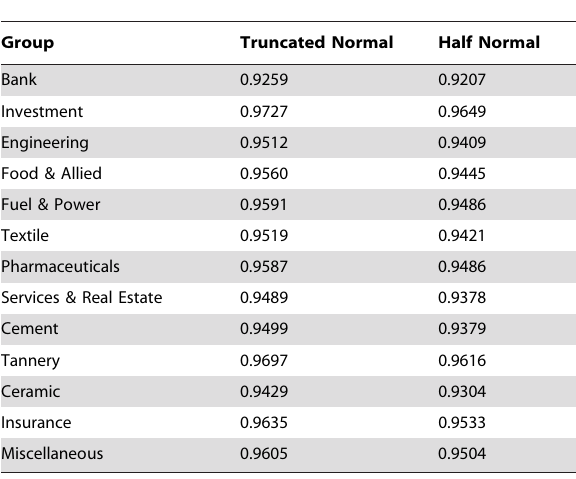
Table 6. Group-wise Mean Efficiency in Dhaka Stock Exchange by distribution with Time-